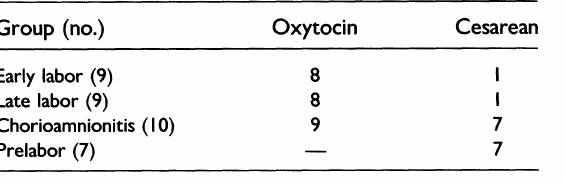
TABLE I. Use of oxytocin and method of delivery in study patients Group (no.)